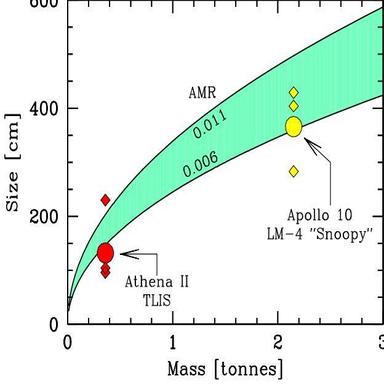
The rendered TLIS (left panel) and Snoopy (right panel) mesh models. A total of 2902 and 11876 facets have been assumed for the two targets, respectively.